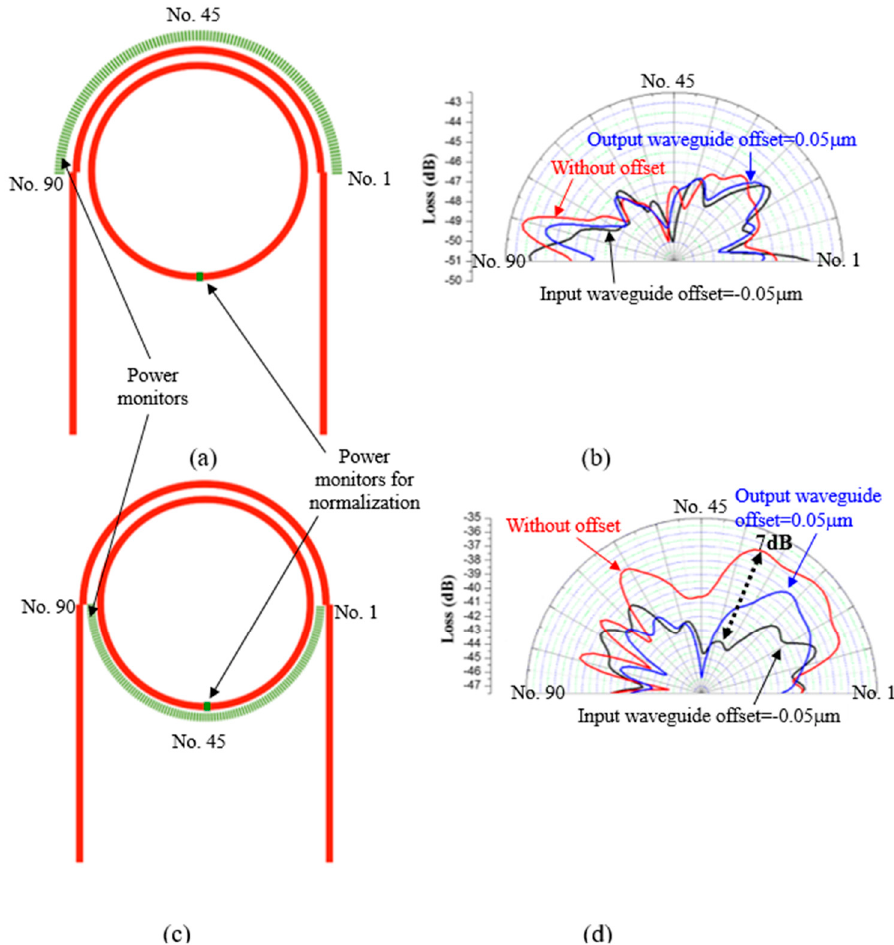
Figure 4. Position and the detected power distribution ( a , b ) for 90 power monitors outside of the curved waveguide, and ( c , d ) for 90 power monitors outside of the ring. The power detected by the 180 power monitors is divided by that of the power monitor positioned on the ring to obtain the normalized optical loss.